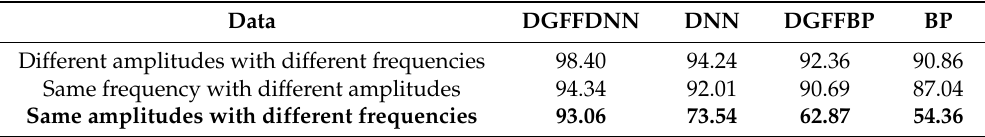
Table 3. Simulation study on accuracies of different fault diagnosis methods.